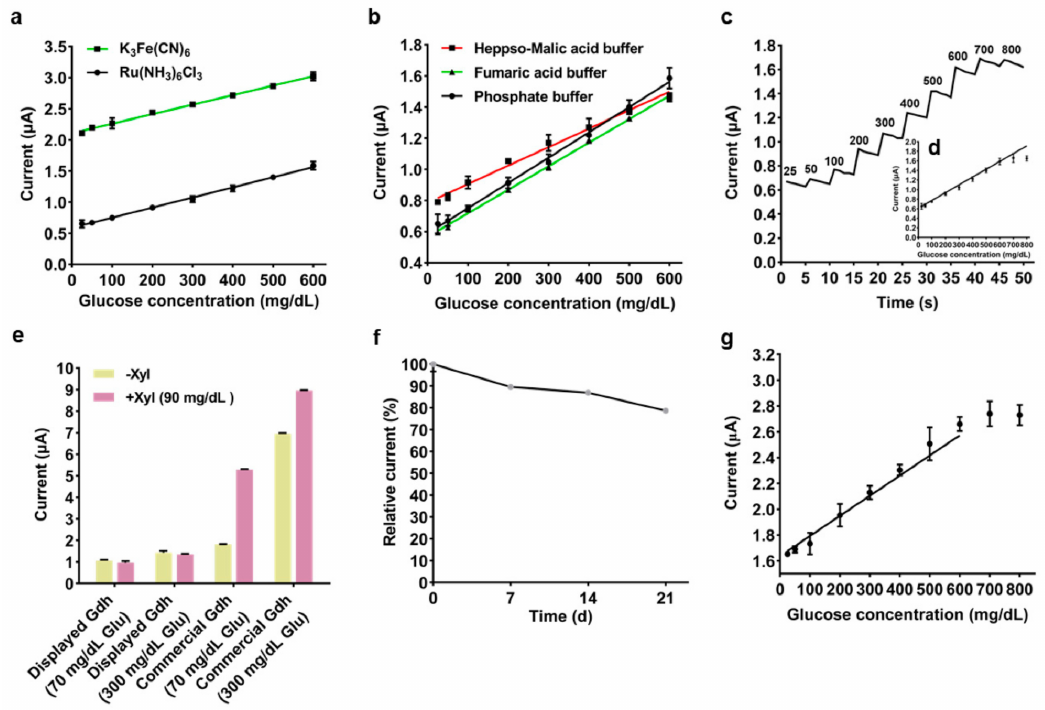
Figure 3. Characterization of the whole-cell glucose biosensor. Effect of ( a ) electron mediator and ( b ) buffer on the glucose biosensor. ( c ) Amperometric response for successive addition of 25, 50 and 100 mg · dL − 1 of glucose. ( d ) The plot of linear regression. The ( e ) anti-xylose performance and ( f ) storage stability of the optimized glucose biosensor. ( g ) The response current of the optimized biosensor to glucose in whole blood samples. Electrochemical detection parameters: voltage 0.3 V, acquisition time 8.5 s. Error bars indicate the SD of samples tested in